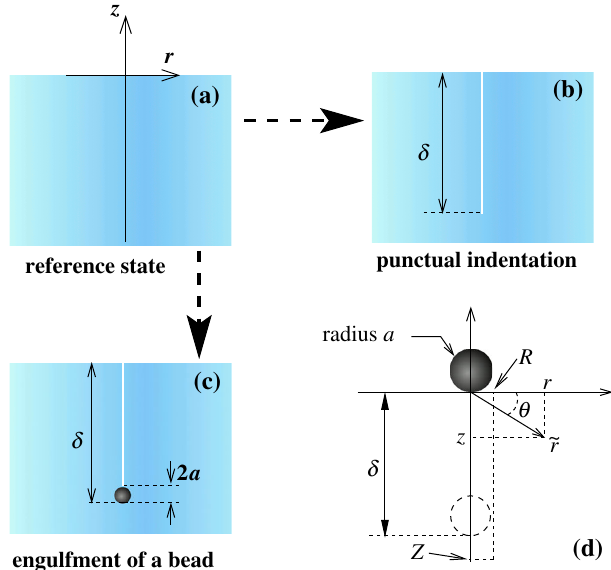
FIG. 4. Sketches corresponding to the steps of the calculation of the elastic energy. (a) Reference state (no deformation). (b) A point load applied at the free surface. The displacement at the application point is δ . (c) A sphere of radius a indents the free surface over the distance δ . (d) Mapping from the reference state (solid lines, with the bead at the surface) to the deformed state. A point of the gel in the rest state is located with coordinates ð r; z Þ . Note that ~ r is the distance from the initial contact point of the bead. In the deformed state, the point that was at ( r , z ) is located at R ð r; z Þ , Z ð r; z Þ